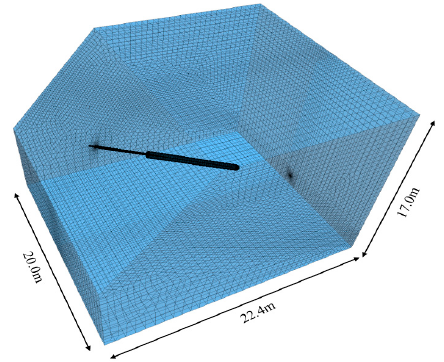
Figure 13. Numerical calculation model.